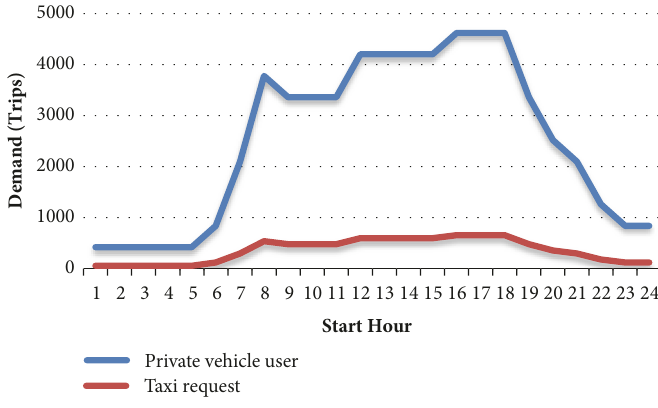
Figure 8: Trip demand by taxi requests and private vehicle users.